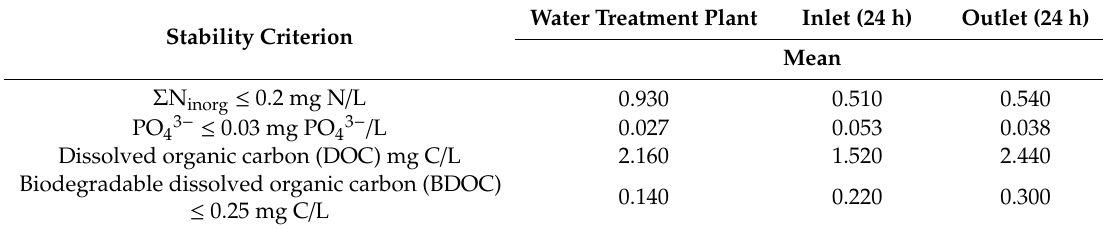
Table 3. Limit values and average concentrations of nutritional substrates in the studied waters (N =